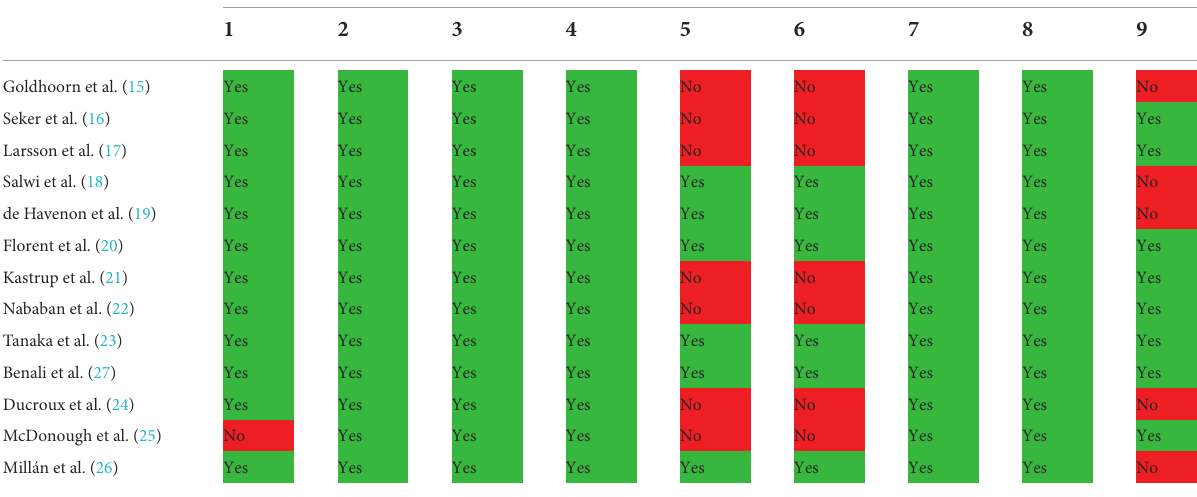
TABLE 2 Results of quality assessment using the Newcastle–Ottawa Scale.